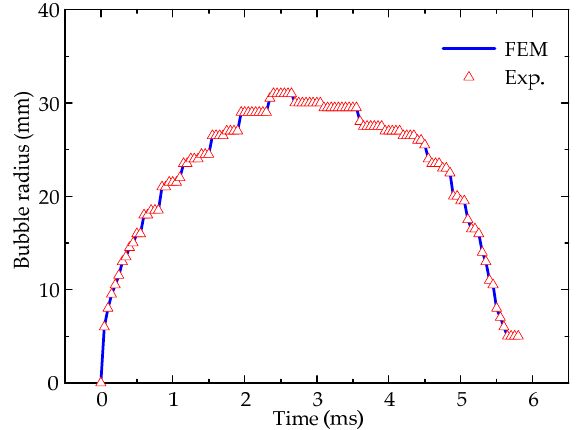
Figure 9. The relationship between the horizontal direction radius of the first pulse period of the free-field bubble and time. The red triangles are the experimental measurement results. The blue line is the ABAQUS/Explicit simulation result.